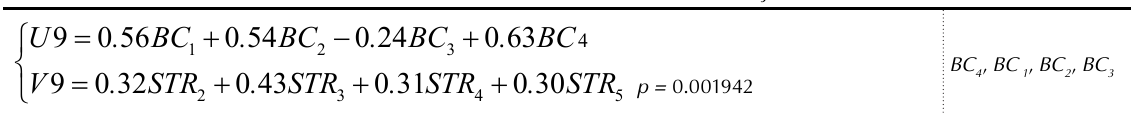
Table 3 (cont.). Canonical models of relationships between the indicators for assessing the banking system financial stability Models of relationships between the indicators for assessing the banking system stability Indicators for assessing the state of bank lending to the economy (U